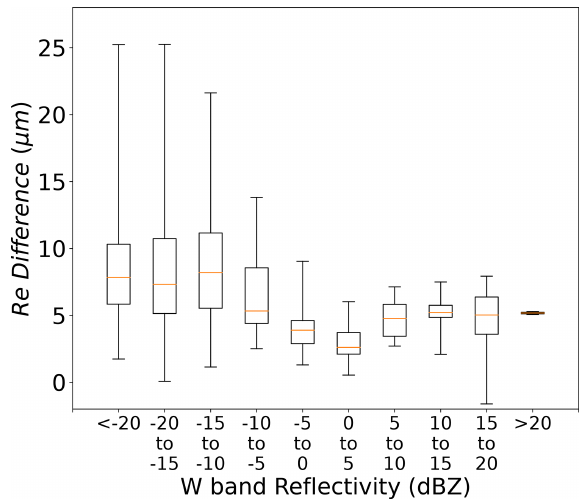
Figure 10. RSP cloud element R e difference using all RSP cloud elements across all RFs, binned by APR-3 W-band maximum re- flectivity intervals of 5dBZ. The orange line indicates the median for each bin, the box ends indicate the interquartile range, and the ends of the whiskers indicate the maximum and minimum values for each